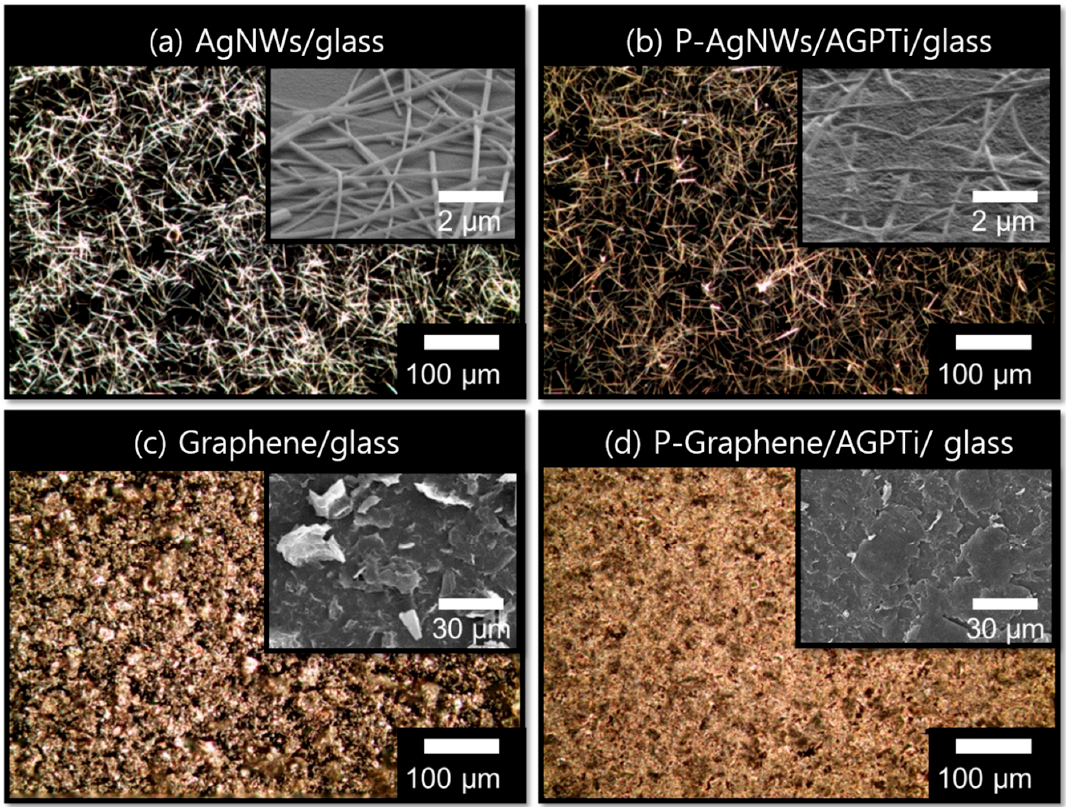
Figure 5. OM and SEM images of the AgNWs and graphene before ( a , b ) and after ( c , d ) the mechanical pressing, respectively.